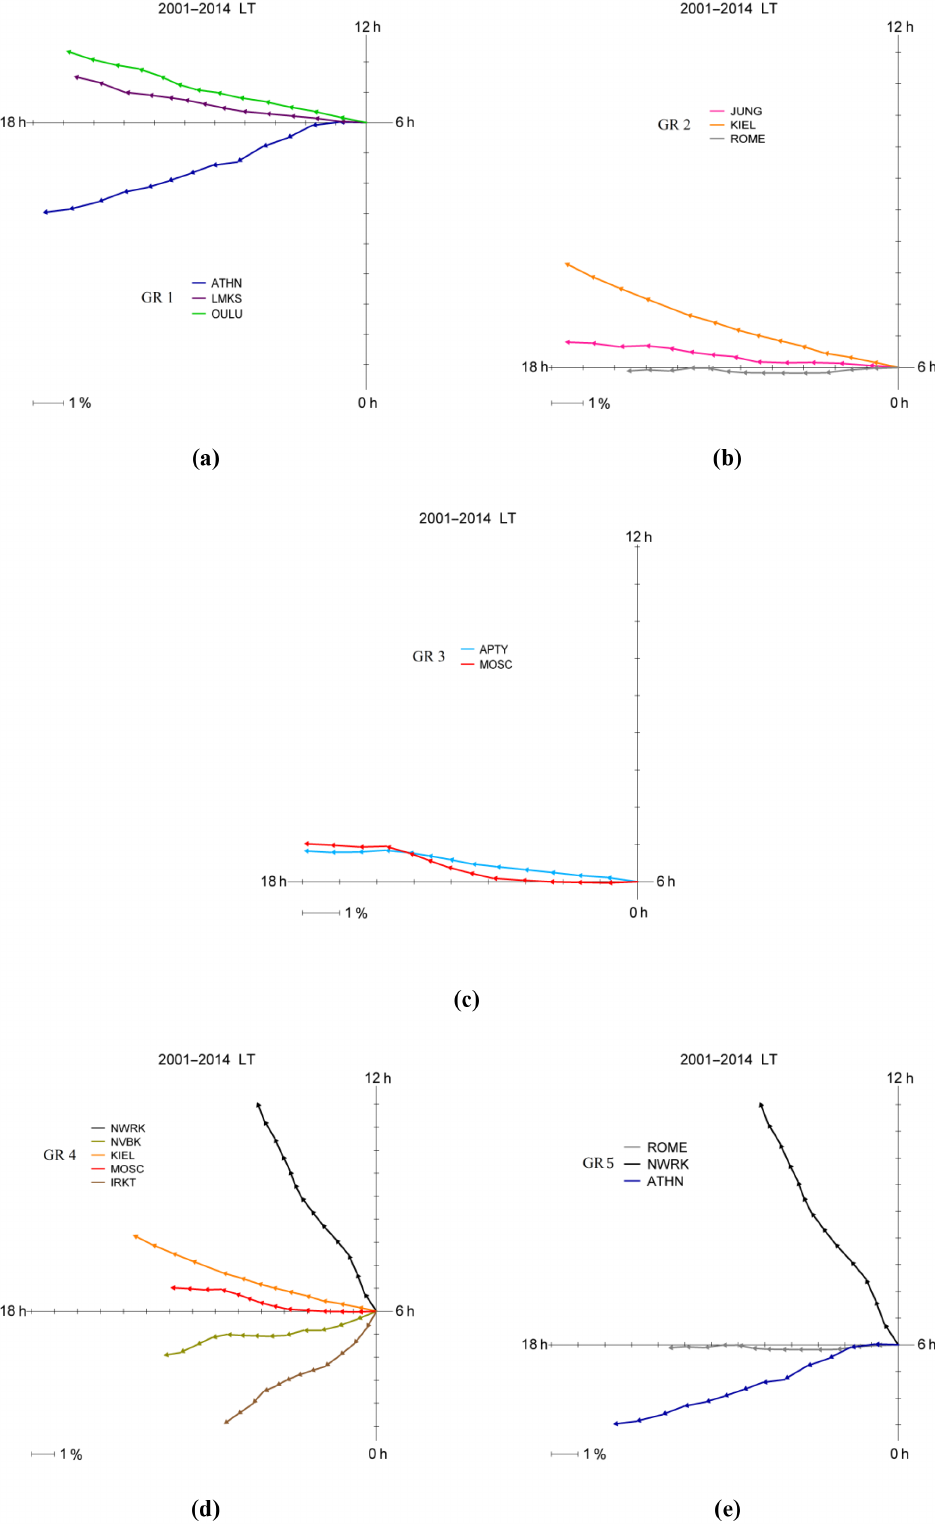
Figure 7. Annual diurnal vectors in LT (a) for GR 1 (ATHN, LMKS, and OULU), (b) for GR 2 (JUNG, KIEL, and ROME), (c) for GR 3 (APTY and MOSC), (d) for GR 4 (IRKT, KIEL, MOSC, NWRK, and NVBK), and (e) for GR 5 (ATHN, ROME, and